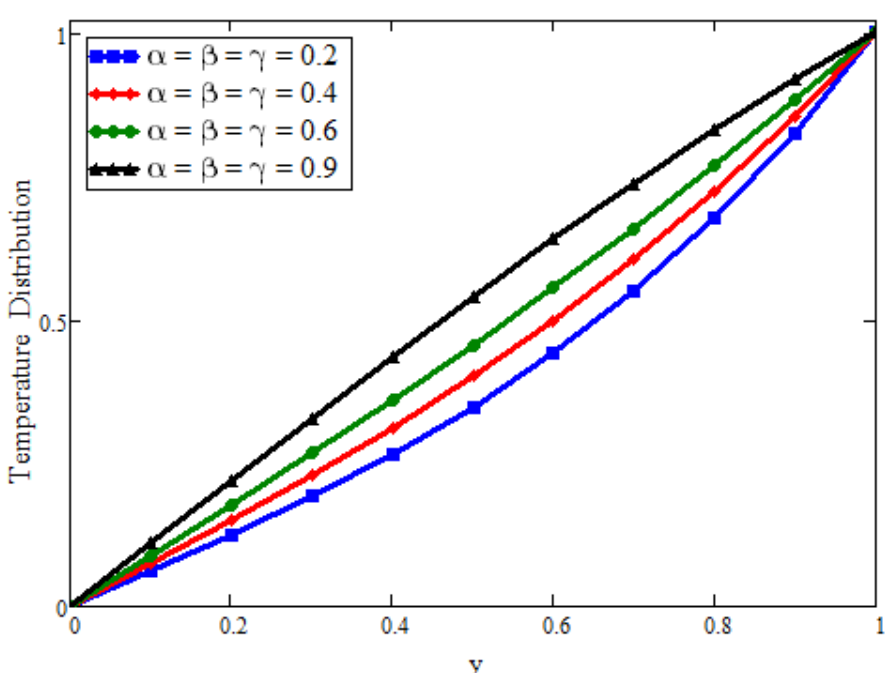
Figure 2. Temperature distribution against y due to fractional parameters α , β , γ for large time, when t = 3 , Pr = 6.2, φ hnf = 0.02.